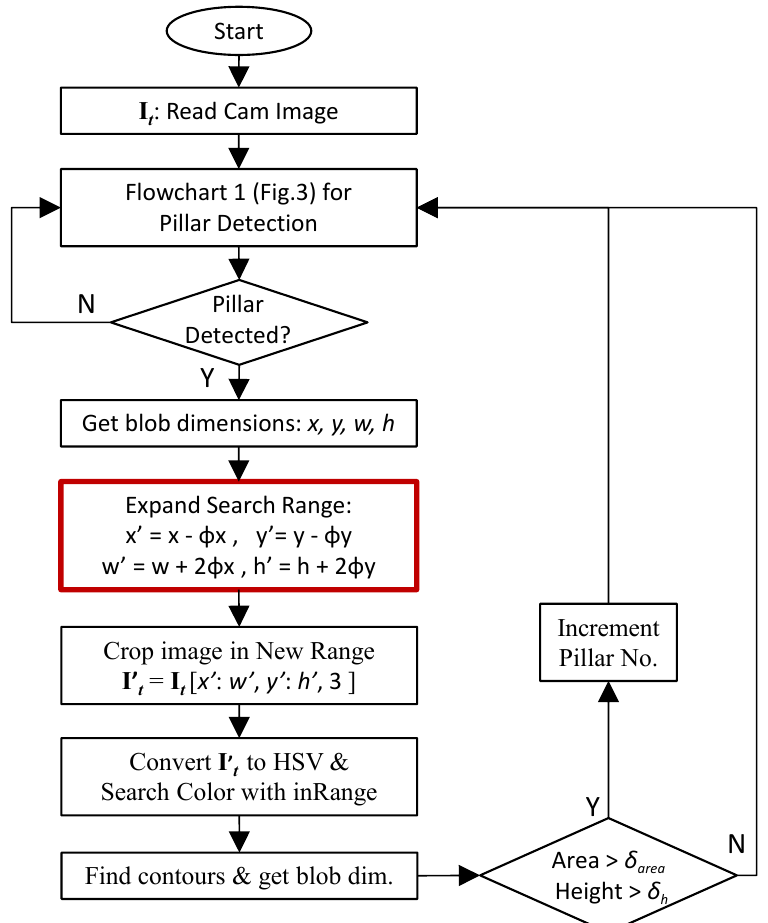
Figure 6. Flowchart of pillar detection in expanded range after initial